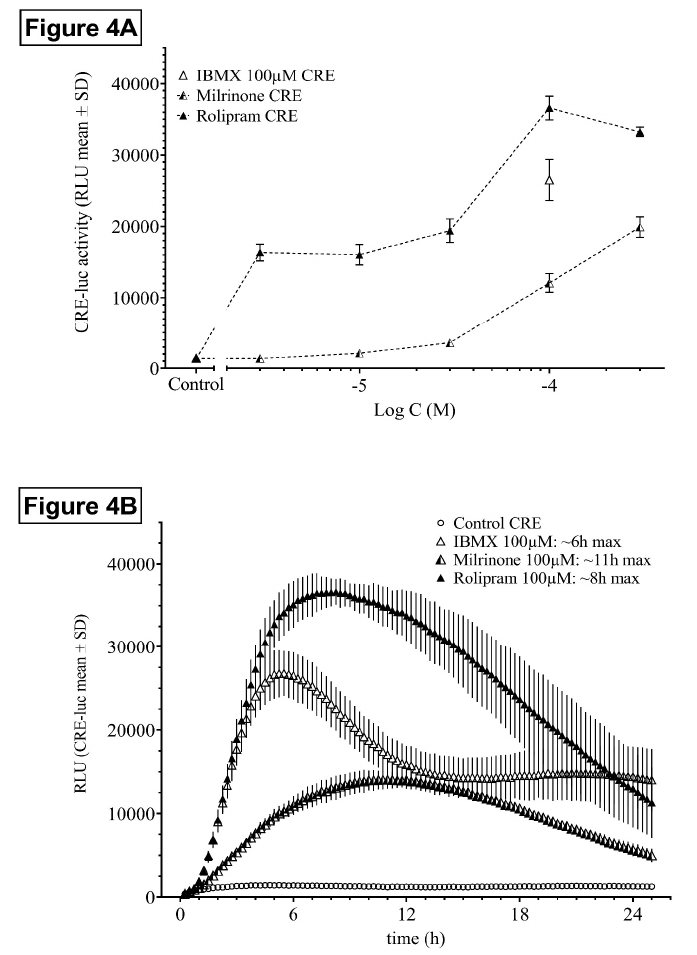
Figure 4. Dose- and time-dependent activity of the PDE-selective inhibitors rolipram and milrinone. ( A ) Dose-dependency of HT22CREluc activity for the PDE4-selective inhibitor rolipram and the PDE3-selective inhibitor milrinone in comparison to IBMX and untreated controls. Mean values with standard deviation (mean ± SD) of four repetitions ( N = 4) are shown. ( B ) Time-resolved curves for all three inhibitors at the same dose (100 µM) in comparison to control (untreated) levels (mean ± SD; N = 4). Note the late onset and maximum activity of milrinone (~11 h) in comparison to rolipram (~8 h) and IBMX (~6 h) and the different offset of activity rates. All data are from the Centro luminometer.